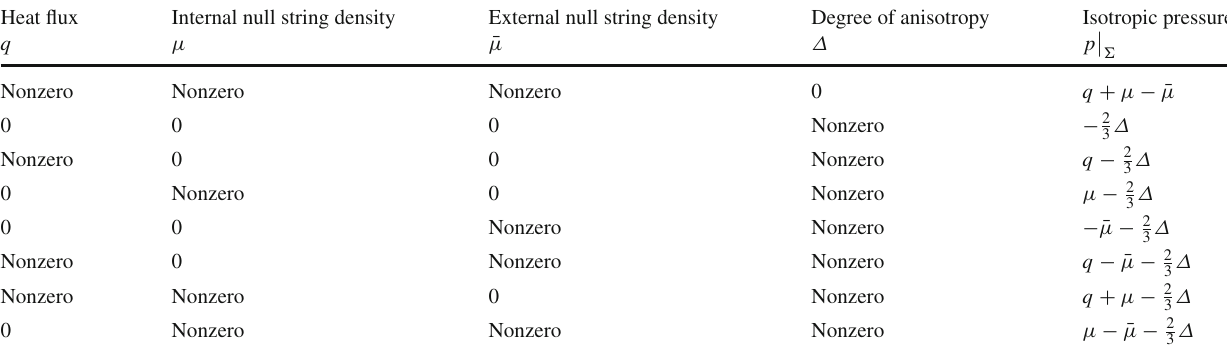
Table 1 Isotropic pressure values on the surface (cid:9) Heat